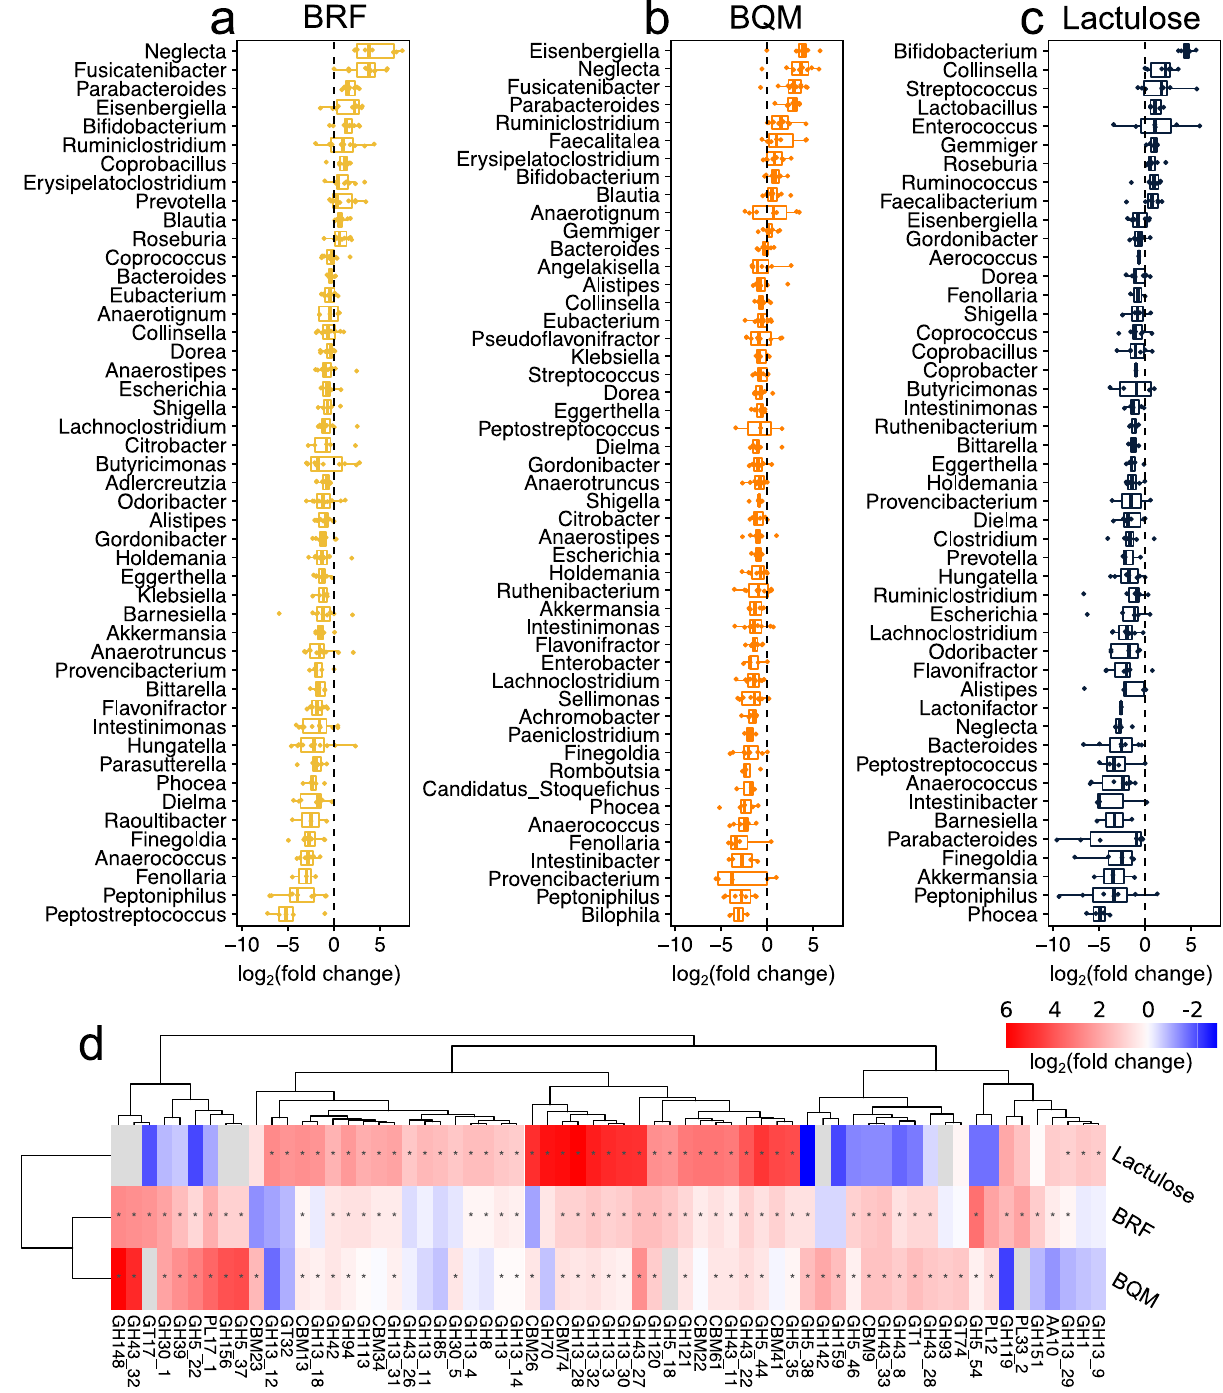
Fig. 4 Changes in fecal community composition in response to glycans across human donors. Differences in relative abundances of genera in ex vivo fecal cultures grown on ( a ) BRF, ( b ) BQM, or ( c ) lactulose relative to no-glycan controls. Data points show median log 2 FC in genus abundances for each donor; box plots show median and interquartile range across donors. Genera with signi fi cant changes ( p < 0.05 after FDR correction) are shown. d Differences in CAZyme gene abundances in ex vivo cultures grown on different glycans (median log 2 FC versus no-glycan controls). CAZyme family/ subfamilies with signi fi cant abundance changes ( p < 0.05 after FDR correction) and log 2 FC > 1 on at least one glycan versus no-glycan controls are shown with hierarchical clustering based on Euclidean distance. Colors are FC with gray showing families not detected in the no-glycan control. Asterisks indicate signi fi cantly elevated abundance. a – d Fecal cultures from healthy donors (ten donors for SGs, seven donors for lactulose) were grown in triplicate for 45 h in MM29 medium supplemented with 5 g l − 1 glycan, as appropriate, and sequenced by metagenomics. Statistical signi fi cance for genus and CAZyme changes was determined by fi tting a linear mixed-effect model on rank transformed genera/CAZyme abundance data with glycan treatment as fi xed effect and subject as random effect. Source data are provided as a Source Data fi le. SGs Synthetic Glycans, FC fold change, FDR false discovery rate, CAZyme carbohydrate-active enzyme, GH glycoside hydrolase, CBM carbohydrate-binding modul, PL polysaccharide lyase, GT glycosyltransferase, AA auxiliary